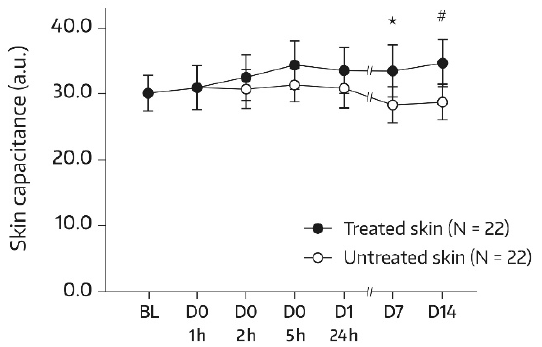
Figure 1. Results from skin capacitance measurements (forearm) in untreated skin and skin undergoing a single application of the face wash gel (first 24 h) followed by twice-daily applications for 13 days. The values were determined using corneometry and are presented as mean ± SD. BL—baseline skin capacitance value before the first product application; D—day; h—hour. * p = 0.026 if compared to the untreated control, as measured using a paired t -test. # p = 0.010 if compared to the untreated control, as measured using a paired t -test.